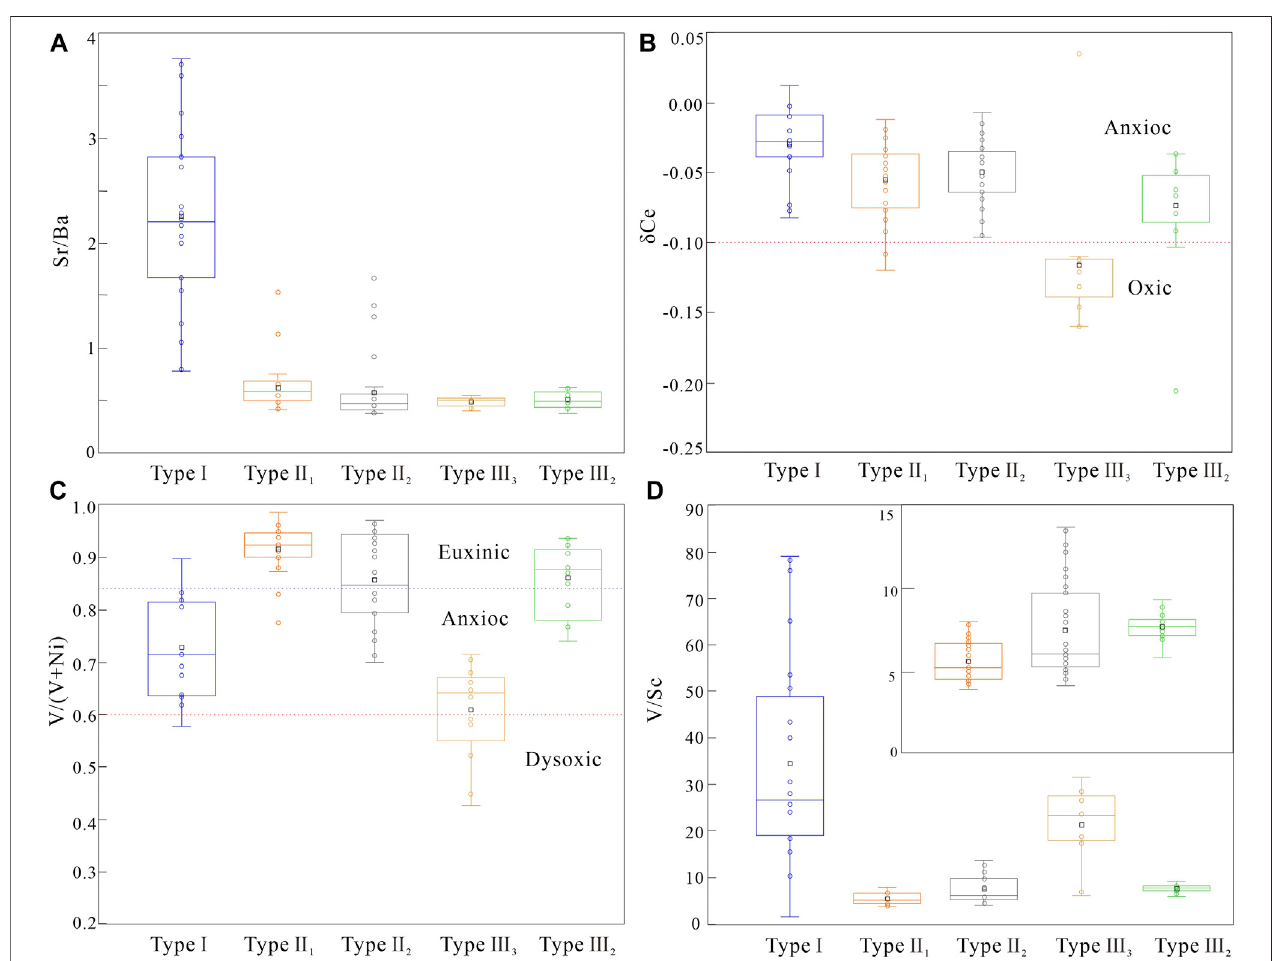
FIGURE 10 | In situ geochemical characteristics of different types of